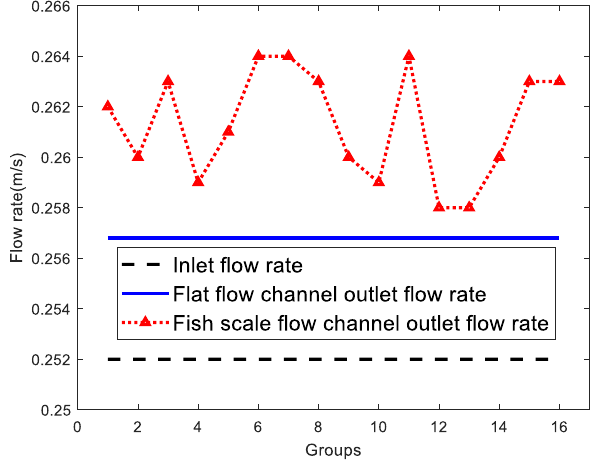
Figure 11 . Comparison of the inlet and outlet flow velocity of 16 groups of BFS channels and the inlet and outlet flow velocity of flat flow channels.